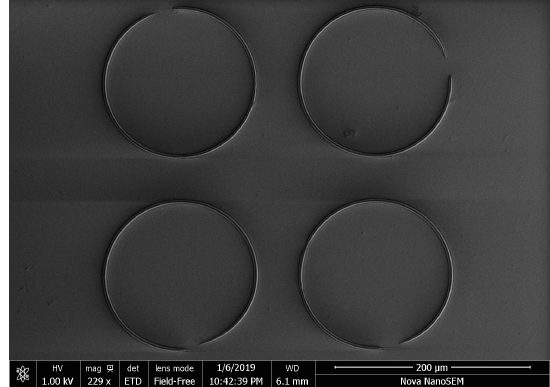
Figure 14. The SEM image of the MSL fabrication